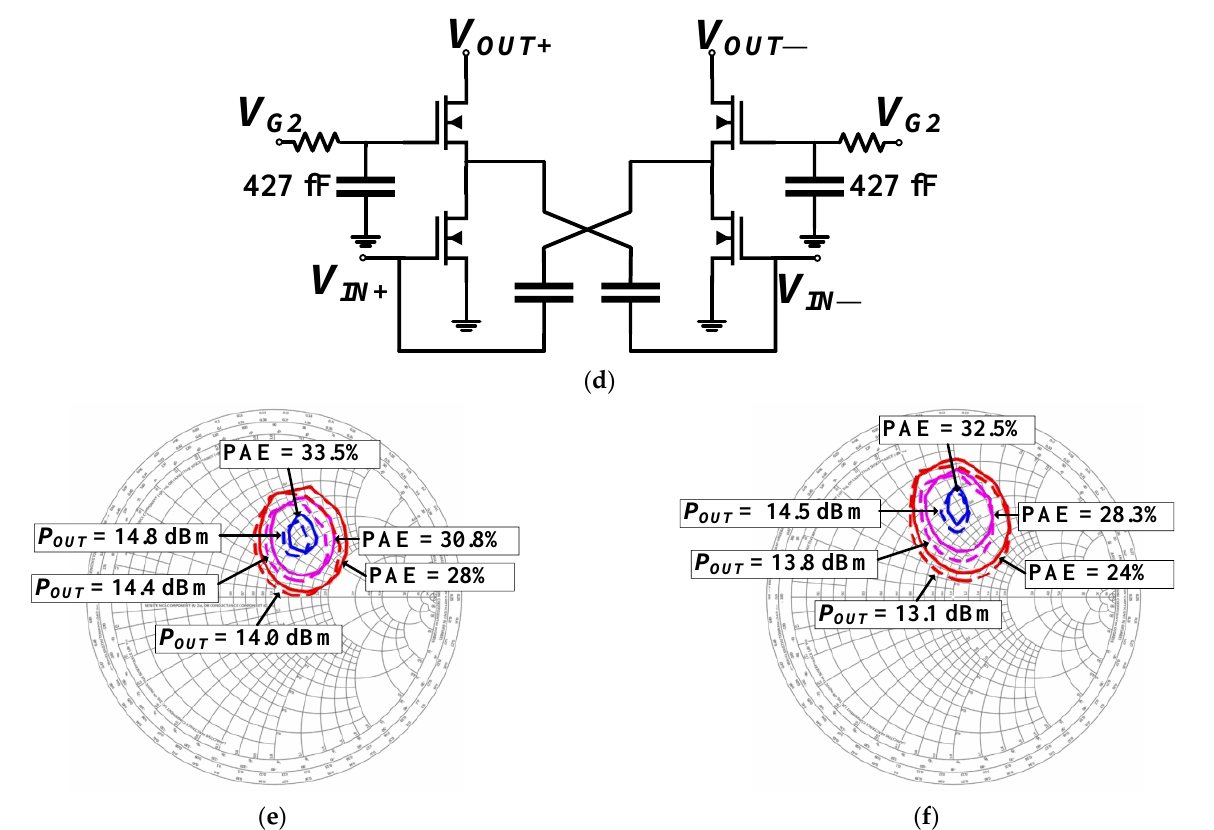
Figure 3. Load-pull simulations of the ( a ) single-ended cascode device pair (with a 427 fF cap on the cascode gate) at ( b ) 24 GHz and ( c ) 37 GHz; and of the ( d ) differential cascode device pair with neutralization capacitors at ( e ) 24 GHz and ( f ) 37 GHz all at around OP 1dB .